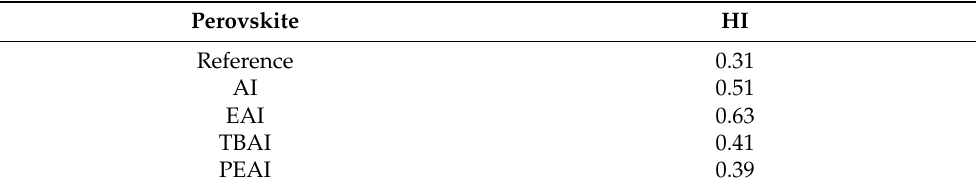
Table 6. Summary table of the Hysteresis Index (HI) that has been calculated for each one of the C-PSCs under study.